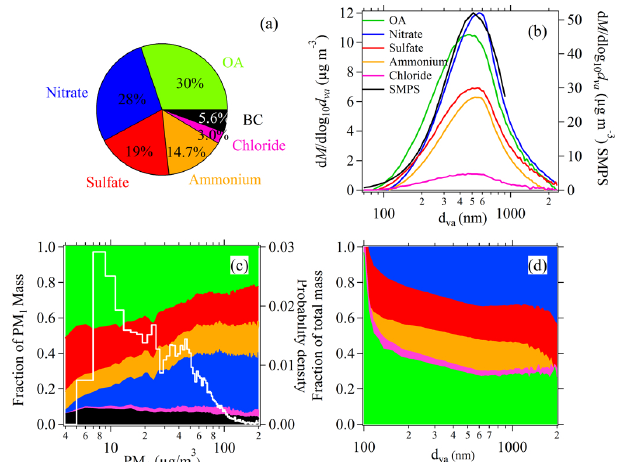
Fig. 2. (a) The average chemical compositions of PM 1 during the campaign. (b) Average size-resolved distributions of AMS species and PM 1 calculated from SMPS. (c) The fractions of main chemi- cal components in PM 1 as a function of PM 1 concentrations (left). Probability density of PM 1 concentrations (right). (d) The fractions of AMS species in total PM 1 as a function of vacuum aerodynamic size ( d va ) . The volume concentration and the mobility diameter measured by the SMPS was converted into vacuum aerodynamic size by a scale factor of 1.5 (approximate density) in both